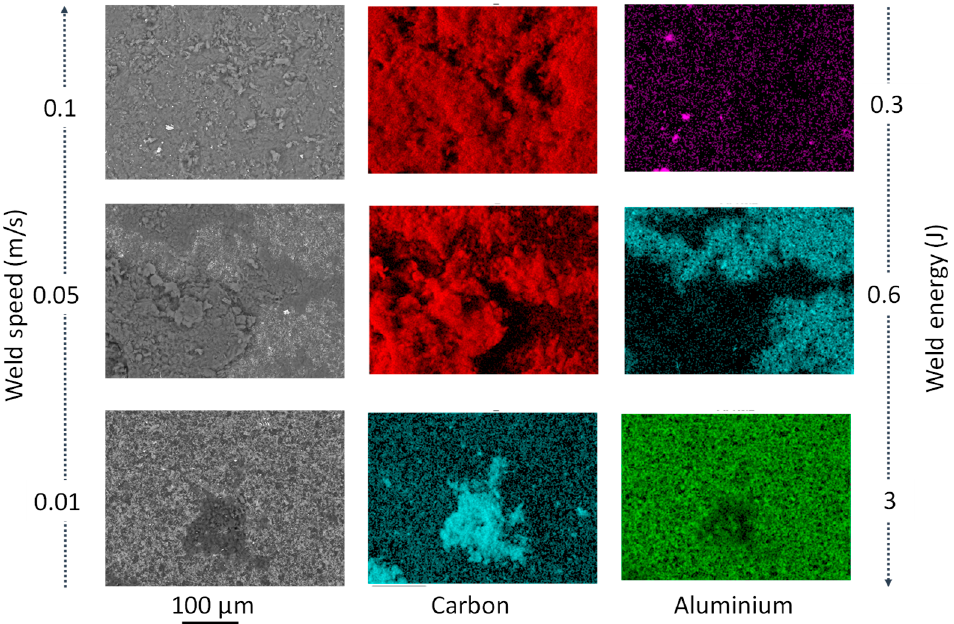
Figure 3. Schematic of the effect of weld speed and weld force variation on the elemental composition results for PcBN samples post-coating (from top to bottom, tests F, D, and E). The 2D topographical data were extrapolated from the scanned profiles using ISO 13565. All 2D measurements for the coated samples resulted in higher roughness compared to the benchmark, with average Ra values in the range 2.4–2.5 µ m for tests B, C, D, F, and G, 1.68 µ m for test A, and significantly lower for test E (1.4 µ m); however, all were significantly higher than the uncoated samples which had an average Ra of 0.5 µ m (Figure 2c). ISO